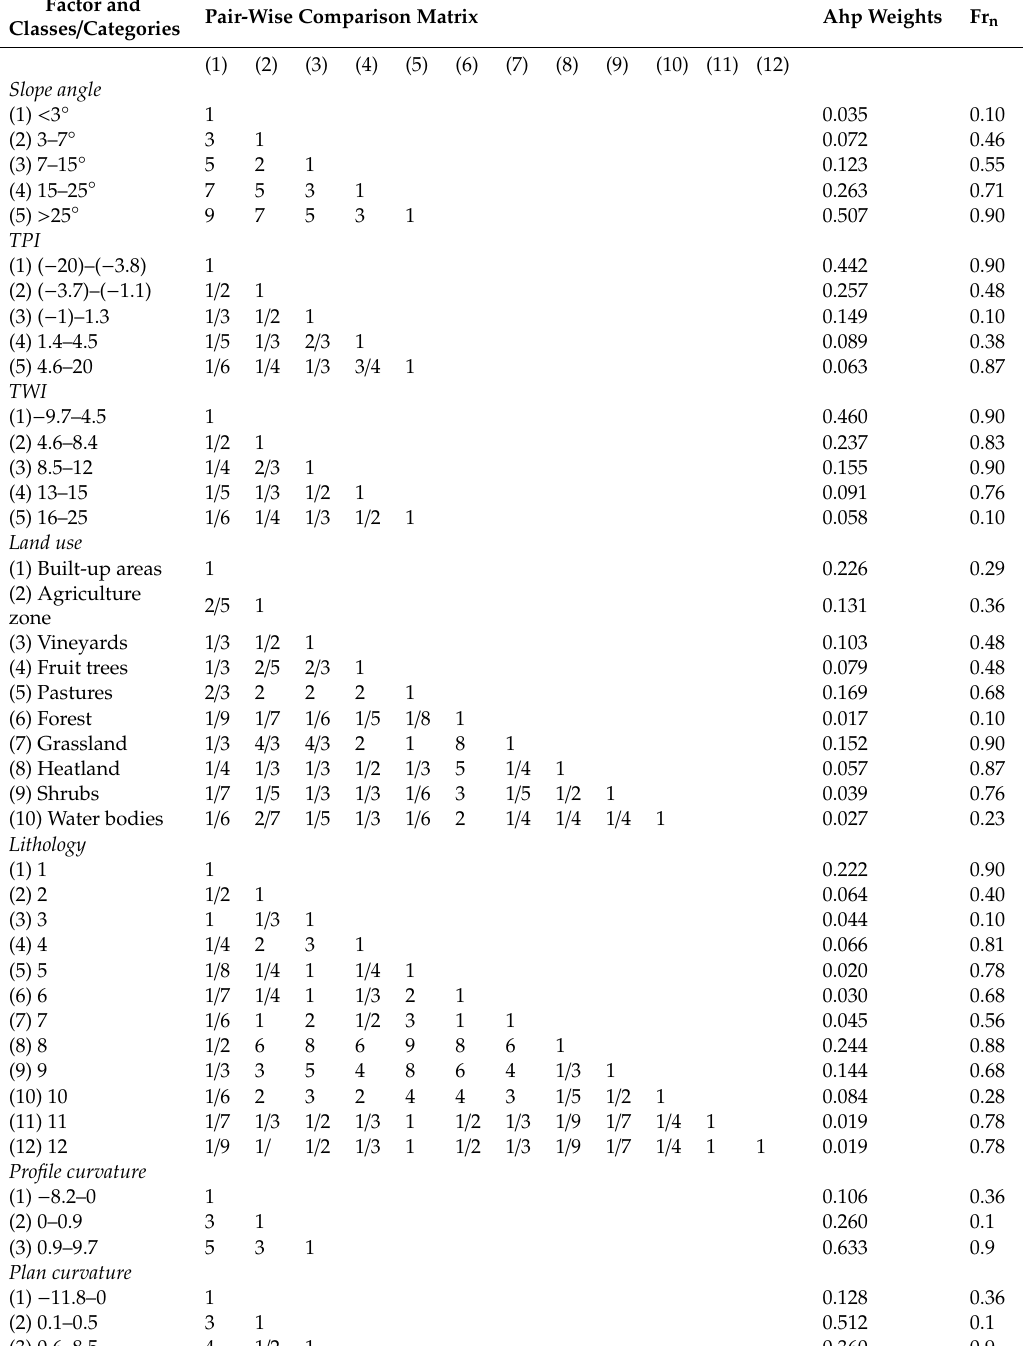
Table 1. Pair-wise comparison matrix and normalized weights for the ten predictors. Factor and Pair-Wise Comparison Classes / Categories